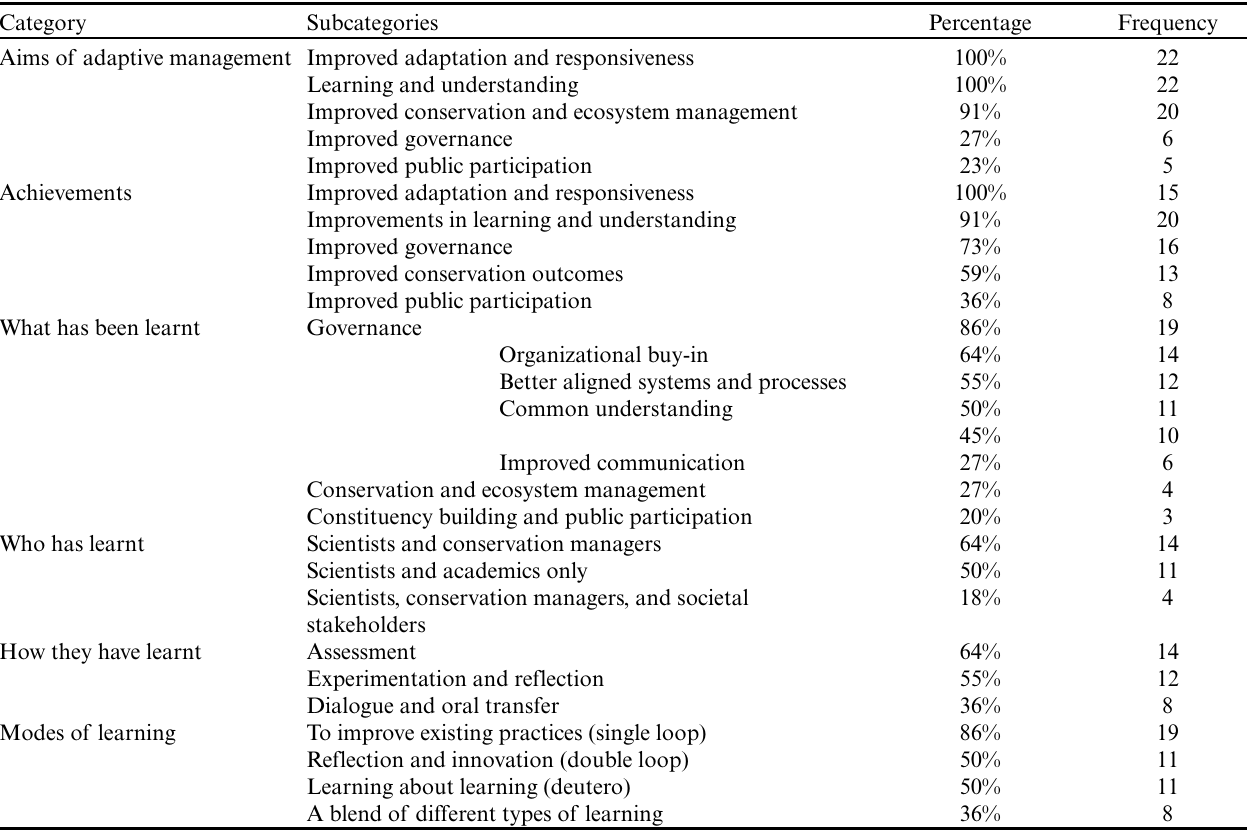
Table 1 . Frequencies of occurrence of various elements of adaptive management appearing in 22 papers published between January 2011 and August 2013. Papers were selected for their focus on the practical implementation of adaptive management, rather than on models and conceptual